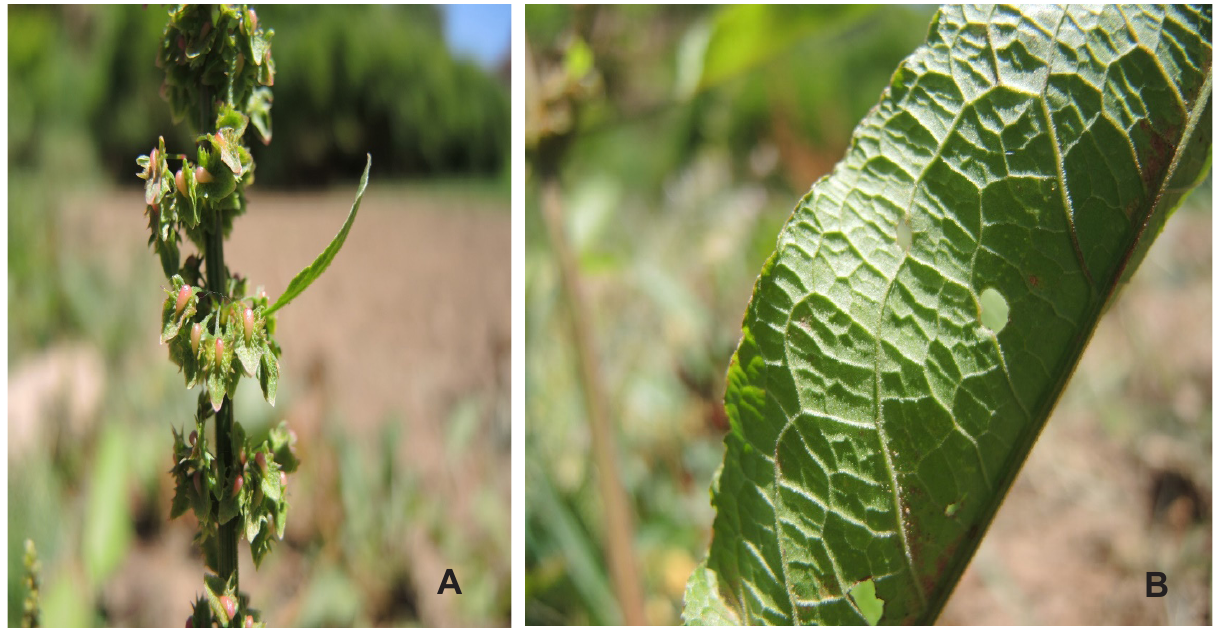
Table 1. Differential diagnostic characters between Rumex chalepensis and R. obtusifolius . R. chalepensis R. obtusifolius All valves with a smooth, well-developed tubercle. Tubercles often unequally developed or only one or two present. Valves with 4 or more teeth on each side. Valves with up to 4 teeth on each side. Valves broadly rounded-cordate in outline (about as long as wide) Valves distinctly longer than wide, veined but less with a very prominent pattern of ± isodiametric veins that covers prominently so. most of the valve surface. Pedicel conspicuously dilated (almost swollen) at apex, just Pedicel at most slightly expanded just below valves. below the valves. Basal leaves ca. 2 – 3 × as long as wide, with abaxial surface Basal leaves 2 × as long as wide, with abaxial surface usually smooth. minutely papillose on the veins, especially near base. Achene ca. 3 mm long or slightly